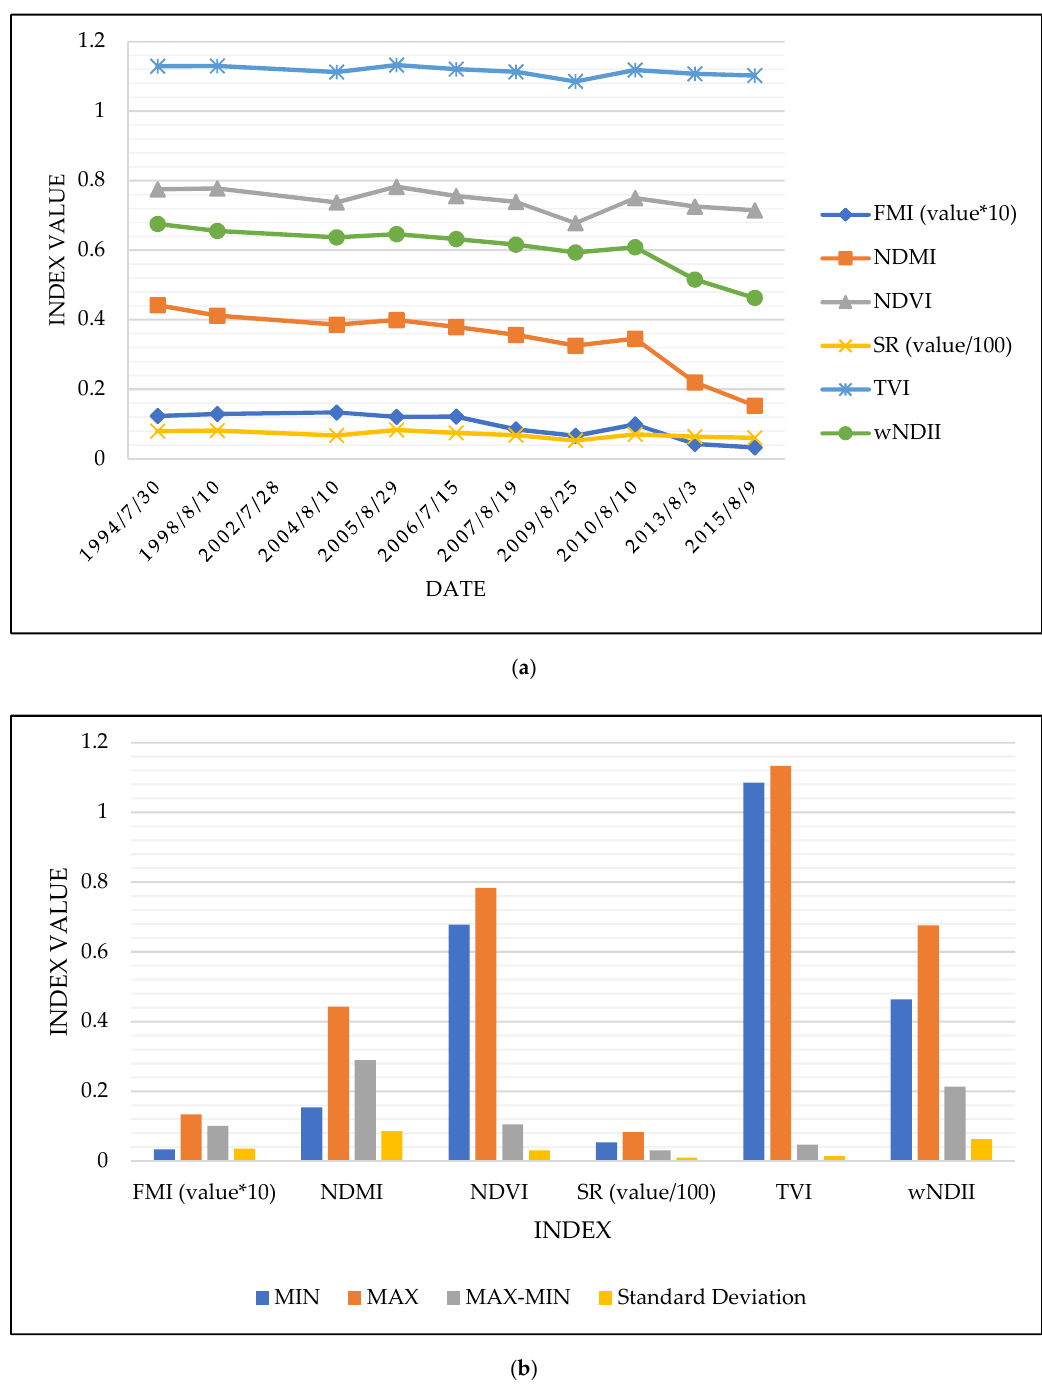
Figure 11. Time series of the vegetation indices for the area affected by the bark beetle ( a ); and the statistical information ( b ) (Locality 7) (Source: Own work).